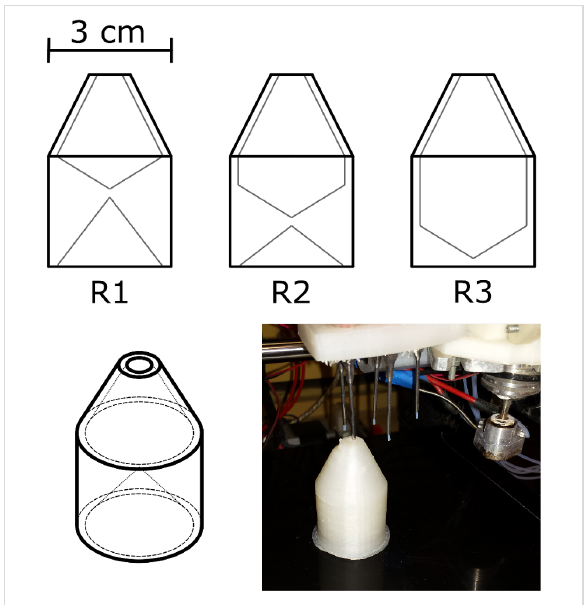
Figure 2: Top: The three reaction vessels printed for ibuprofen synthe- sis on different scales; bottom left: isometric representation of a reac- tion vessel; bottom right: reaction vessel in situ during the synthesis of ibuprofen, showing the insertion of the PTFE-lined dispensing needle into the